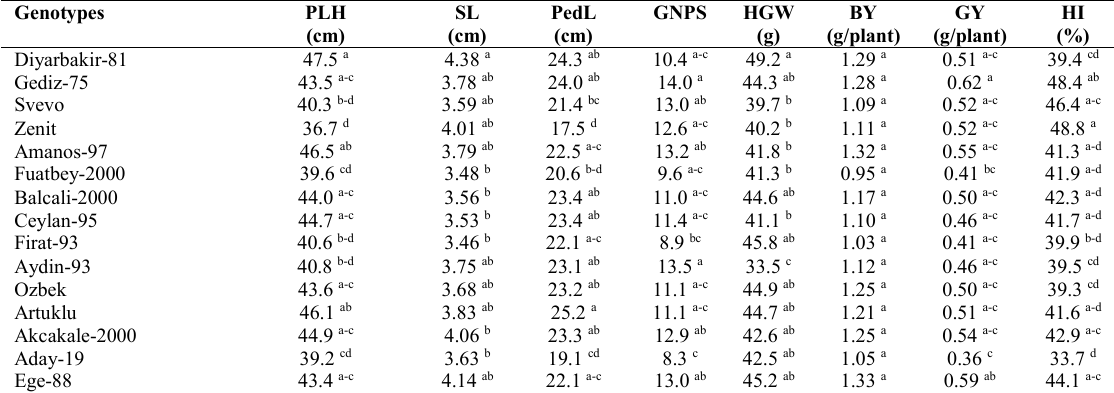
Table 5. Mean comparison of different traits of studied durum wheat genotypes using Duncan’s multiple range